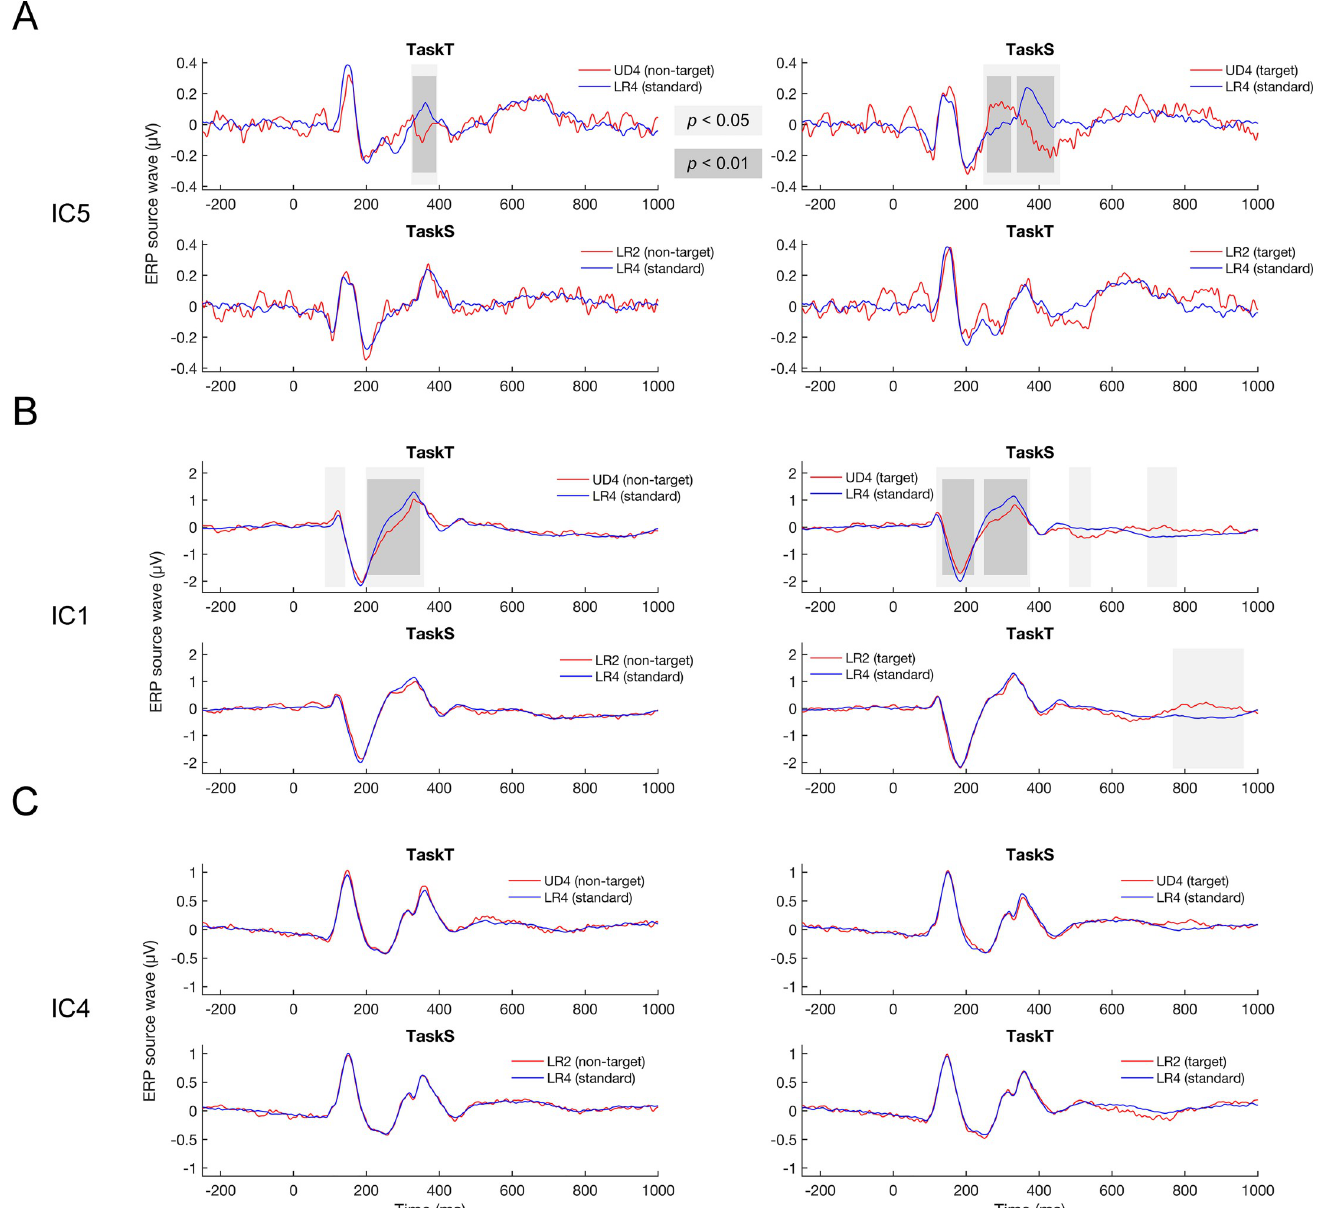
Fig 5. Responses arising from the visual cortex. (A) Significant differences occurred between IC5 to standard and non-target stimuli in TaskT, within the time range of 324–392 ms. Similar response differences were also observed in TaskS between IC5 to standard and target stimuli, within the time range of 334–456 ms. (B) Significant differences occurred between IC1 to standard and non-target stimuli in TaskT, within the time ranges of 88–140 ms and 200–356 ms. Similar response differences were also observed in TaskS between IC1 to standard and target stimuli, within the time ranges of 120–222 ms and 224–374 ms. In addition, significant differences occurred at a relatively late stage (later than 698 ms) between IC1 to standard and target stimuli in both TaskS and TaskT. (C) No difference was observed in either TaskT or TaskS between IC4 to standard and non-target stimuli or between IC4 to standard and target